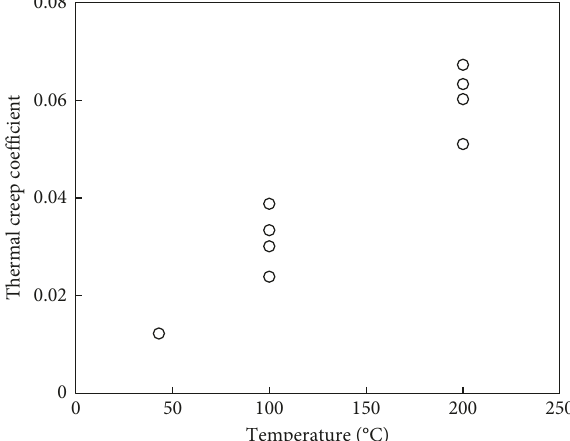
Figure 2: Evolution of the thermal creep coefficient of Pacific illite